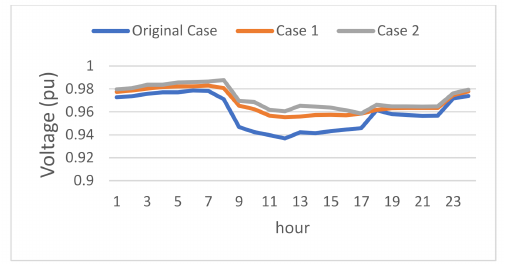
Figure 8. The daily minimal voltage profiles of all buses.